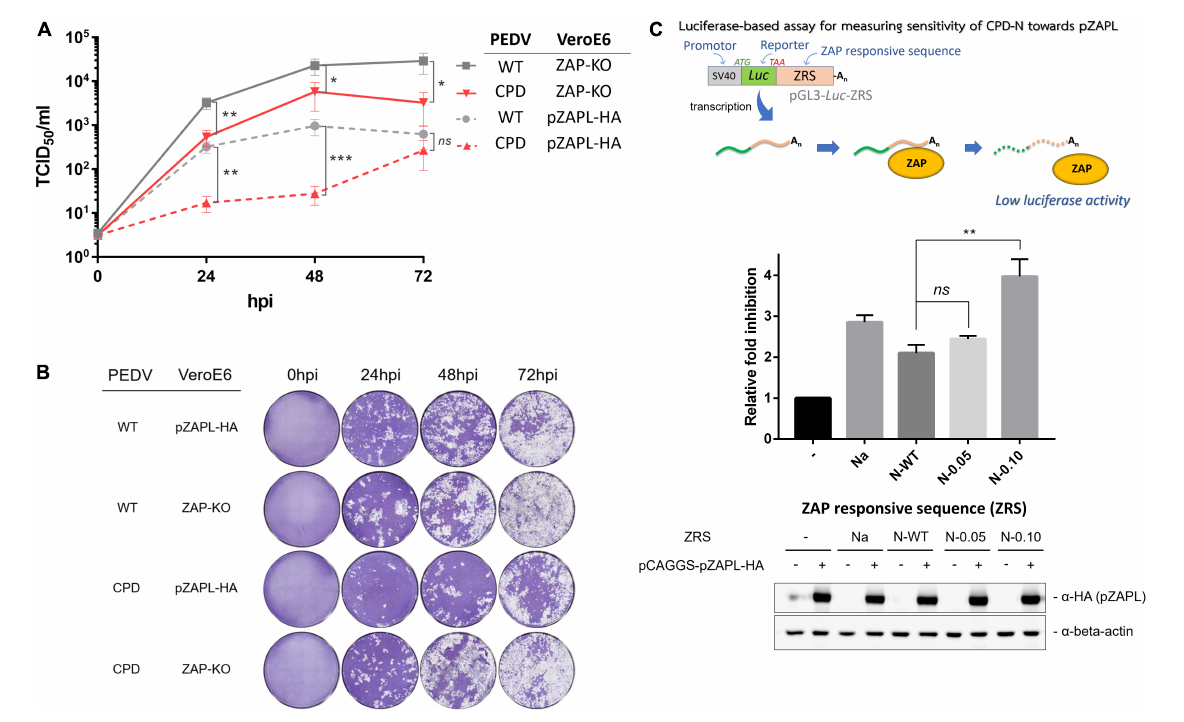
FIGURE4 The growth of CPD-porcine epidemic diarrhea virus (PEDV) is suppressed by porcine zinc-finger antiviral protein (ZAP). (A) VeroE6 ZAP-KO or VeroE6-pZAPL cells were infected with CPD-PEDV at MOI = 0.001. Viral growth kinetics in VeroE6 ZAP-KO or VeroE6-pZAPL were monitored at the indicated time points using the TCID 50 assay. Values shown are averages ± SEM of three independent experiments (Student’s t -test, ** p < 0.05, ** p < 0.005, *** p < 0.0005). (B) Representative viral spread at varied time points from A) was shown as images of CPE. (C) (Top) Schematic representation of the luciferase-based assay used to measure the sensitivity of each ZRS to pZAPL. (Middle) Each reporter plasmid containing ZRS was transfected into the ZAP-KO-293T cells along with a transfection normalizing plasmid, pRL-TK, and an empty control plasmid or a pZAPL-expressing plasmid. At 48 hpt, the transfected cells were lysed and luciferase activity was measured using the dual-luciferase reporter assay. The sensitivity of each ZRS to pZAPL was compared as the inhibition fold, which was calculated as described in methods. Inhibition data shown are the means ± SD of three independent measurements (Student’s t -test, ** p < 0.005). (Bottom) SDS-PAGE/western blot showing expression of pZAPL in each